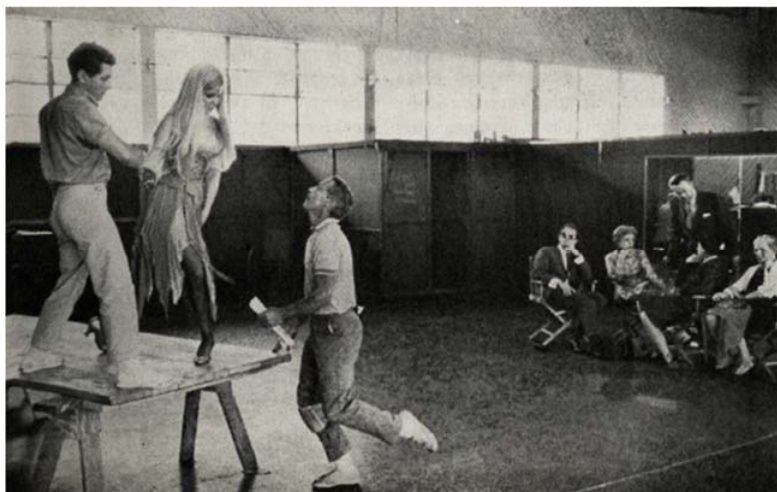
Brother Grimm (1962). Photographs by Seymour Linden for Dance Magazine (January 1962).